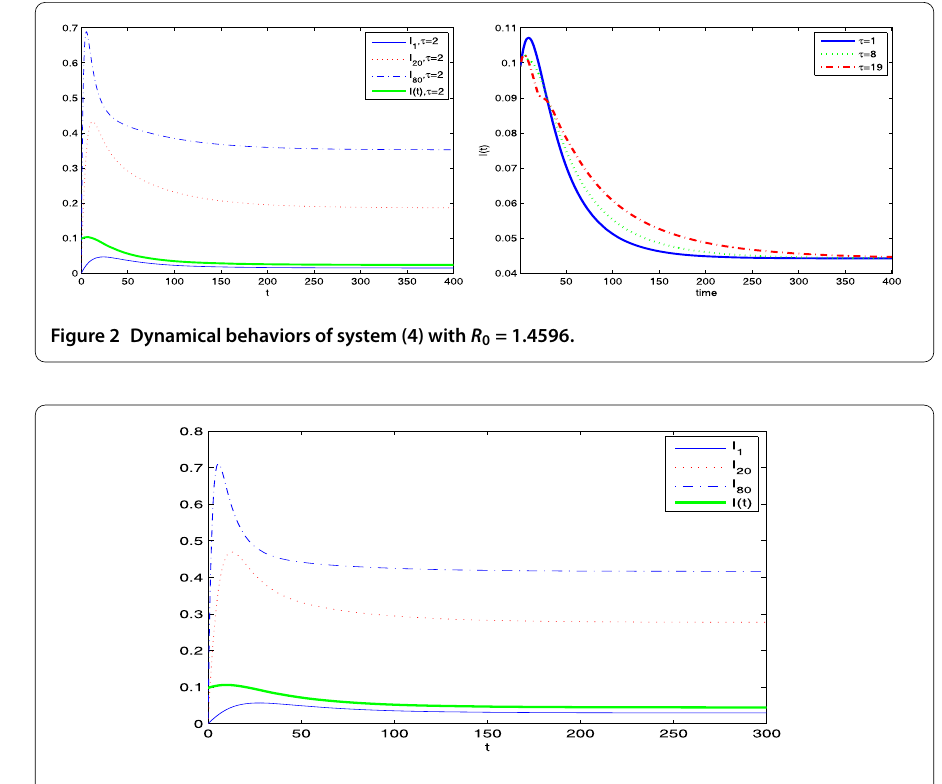
Figure 3 Dynamical behaviors of system (4) with τ = 2 and R 0 =